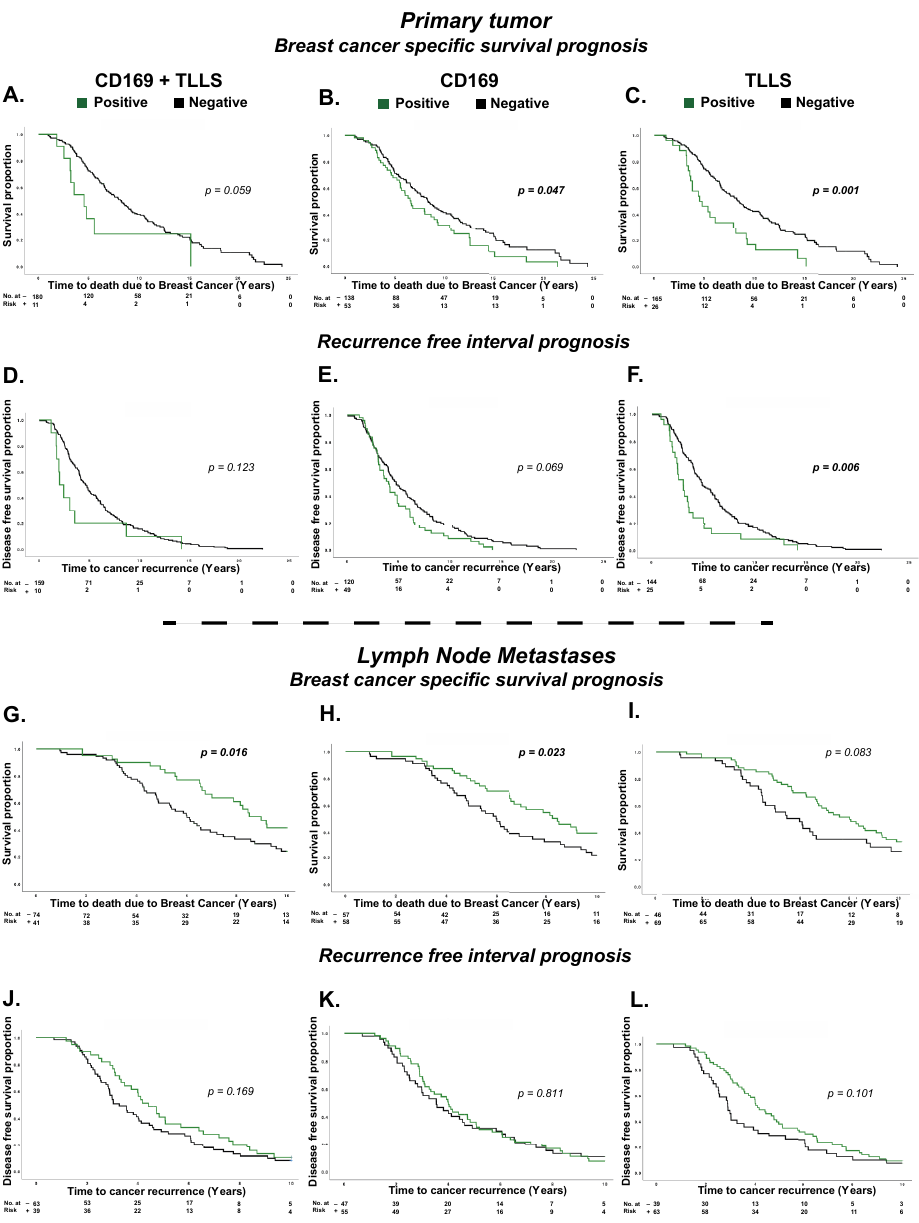
Figure 2. Kaplan–Meier survival plots investigating differences in 25-year breast cancer specific survival (BCSS) and recurrence free interval (RFI) for specific immune cell populations infiltrating tumors. P values by the log-rank test are highlighted in bold when significant. In panels ( A–F) , the impact of immune cell infiltration for CD169 + TAMs, TLLSs and CD169 + TAMS/TLLS was investigated as prognostic markers for BCSS and RFI in primary tumors (PTs). In panels ( G–L) , the impact of CD169 + TAMs, TLLSs and CD169 + TAMS/TLLS on BCSS and RFI was investigated in lymph node metastases (LNMs). Green lines indicate PTs and LNMs with CD169 + TAMs, TLLSs or CD169 + TAMS/TLLS infiltration, and black lines indicate the absence of CD169 + TAMs, TLLSs or CD169 + TAMS/TLLS.